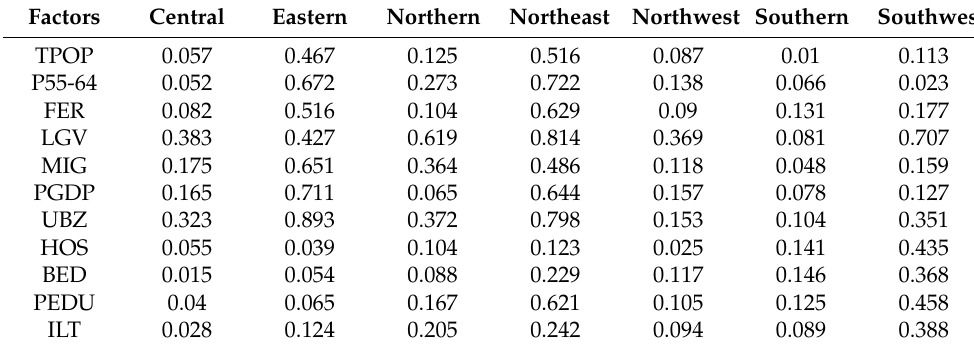
Table 4. The q-statistics of the factor detector in various regions. Factors Central Eastern Northern Northeast Northwest Southern Southwest